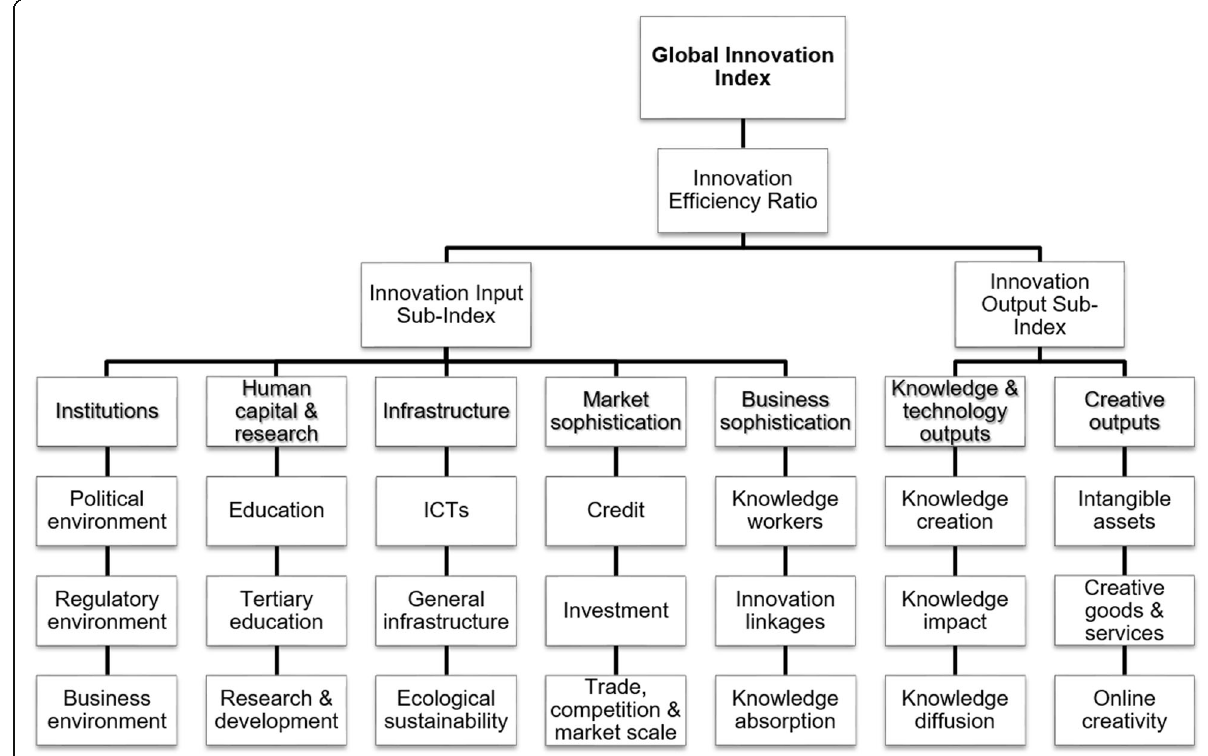
Fig. 1 Framework of the Global Innovation Index 2017. Source: Cornell University et al., 2017, p.